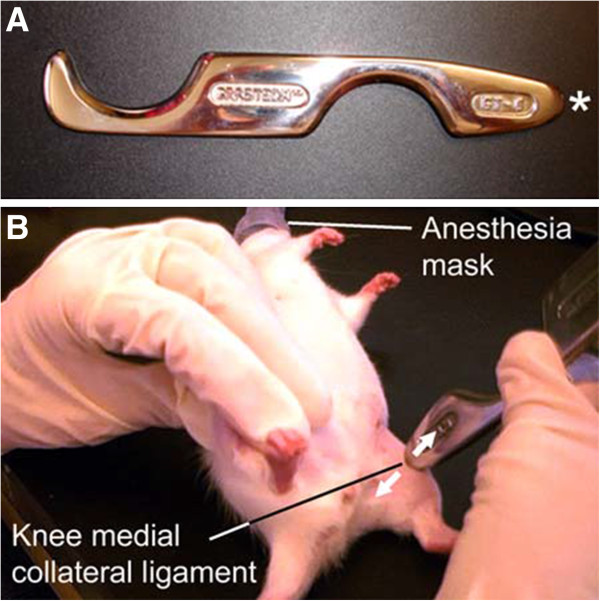
Instrument-assisted cross fiber massage (IACFM) intervention. A: The rigid Graston Technique® GT6 tool fabricated from stainless steel has a tapered tip (*) which permits treatment of small structures. B: IACFM of the rodent knee joint medial collateral ligament using the GT6 tool. Arrows indicate the direction of movement/force application perpendicular to the collagen substructure of the ligament.